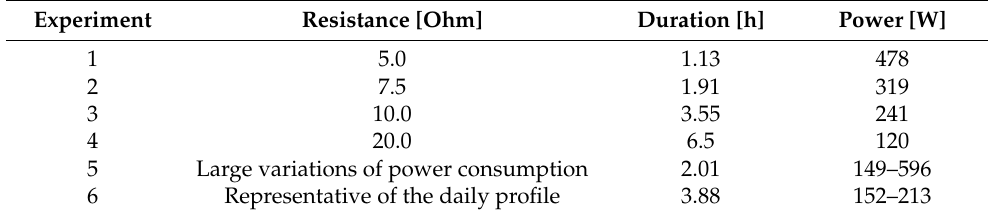
Table 1. Experimental parameters for the test performed with the MH2-Powerbank system, using scenario C.